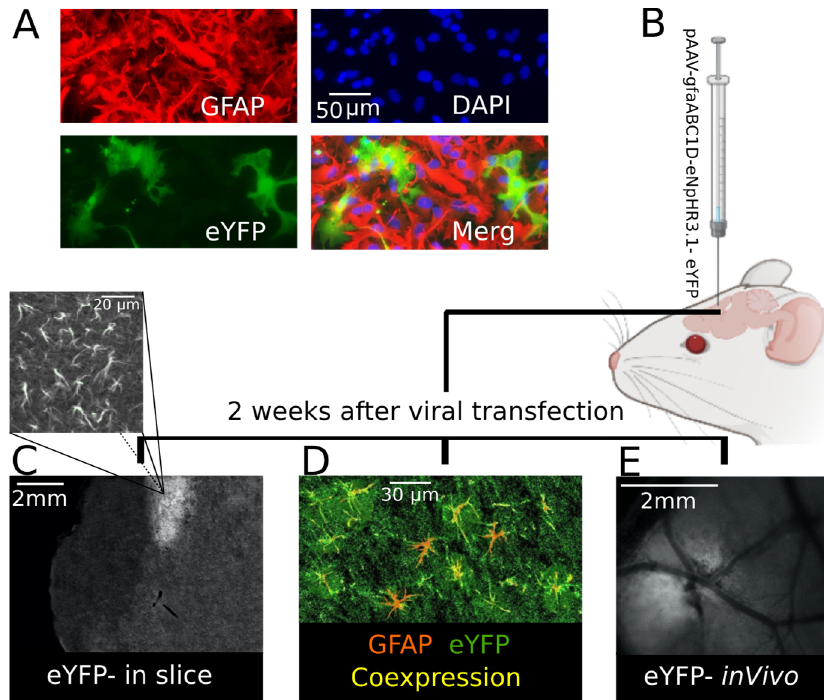
Figure 1. eYFP (conjugated with eNpHR) was confirmed to be expressed in mouse astrocytes. ( A ) Astrocyte-specific expression of eNpHR-eYFP (green) throughout the GFAP-positive astrocytes (red); they are shown as merged (yellow) to illustrate eNpHR and astrocyte colocalization in mouse cell culture. ( B ) CD-1 mouse viral transfection; 2 weeks after transfection. ( C ) Injection site expressing eYFP in a mouse brain slice; in the image above ( C ) it is magnified to show astrocytic-like processes. ( D ) Astrocytes (GFAP-positive (red)) expressing eNpHR (eYFP-conjugated (green)) shown in yellow to illustrate co-expression (yellow) in a mouse brain slice. ( E ) The injection site was distinguishable in vivo because of eYFP expression 2 weeks following mouse transfection.